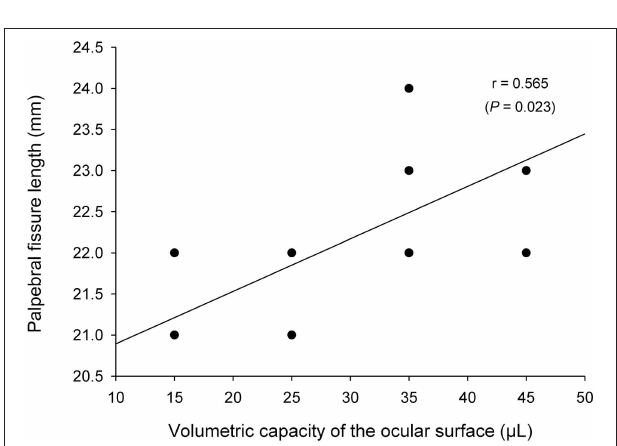
FIGURE 3 | A positive association was found between the length and the volumetric capacity of the palpebral fissure (Pearson’s correlation